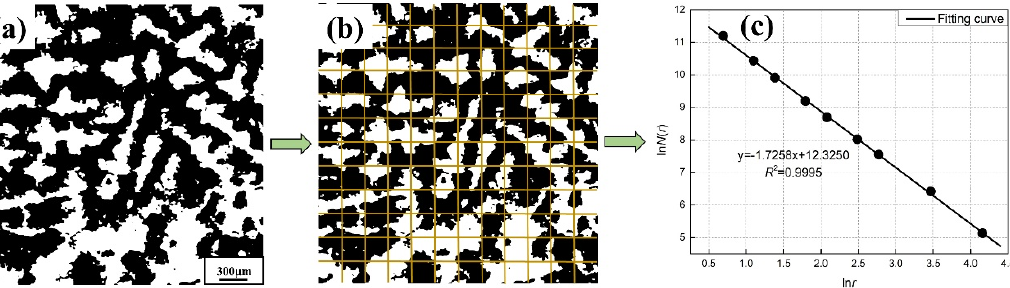
Figure 2. Calculation process of fractal dimension: ( a ) the original solidification structure (white regions); ( b ) box grids overlaid on the solidification structure; ( c ) relation between lnN(r) and lnr for the fractal dimensions.